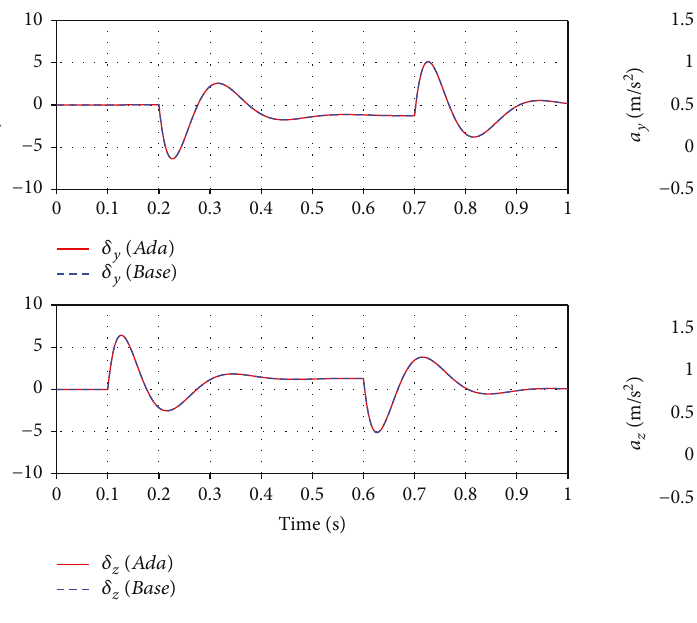
Figure 4: The nominal case control signal.